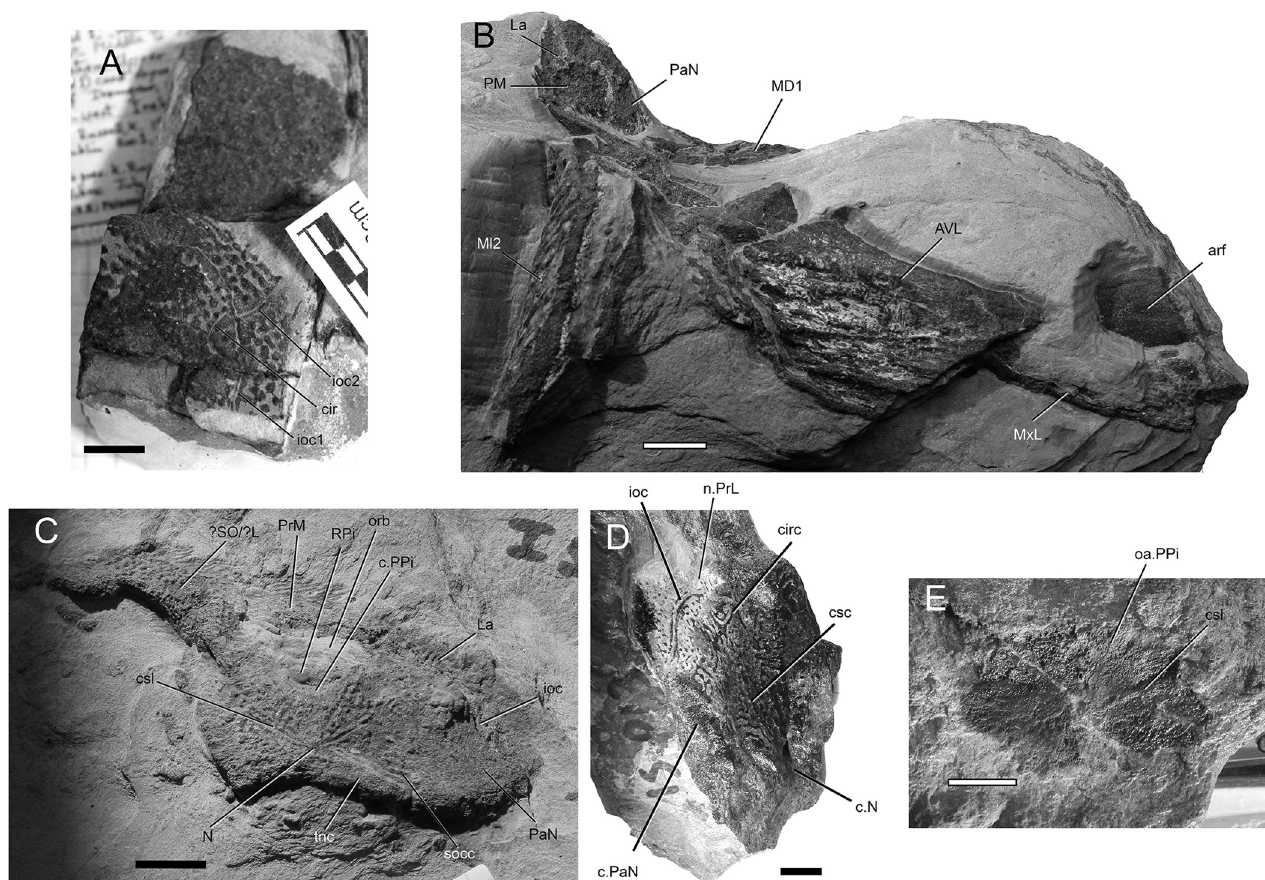
Fig 3. Bothriolepis dairbhrensis sp. nov. A. Undetermined and incomplete right lateral plate in external views, NHM P 59678. B. Incomplete lateral portions of the skull roof and of the plastron and fin in internal views, NMING:F35204. C. Incomplete skull roof in external view, NMING:F35205. D, left lateral plate in external view, NMING:F35206. E. Incomplete nuchal plate in dorsal view, NMING:F35207. Scale bars 10 mm.